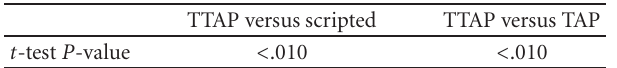
Figure 17: Generality test results for the temporal TAP adaptation framework: plot of S against number of iterations. A single point on the graph represents a full game episode. S depicts the performance di ff erence in TTAP team versus scripted team. Table 5: Generality and improvement test results of the temporal TAP adaptation framework: table of t -test P -values.